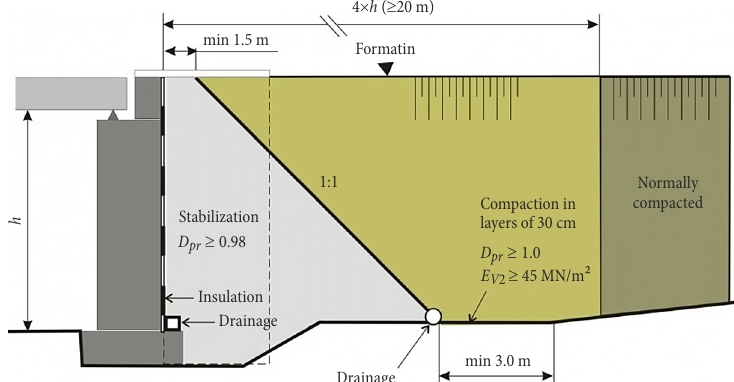
Fig. 11. The stabilization zone in the bridge-embankment transition area